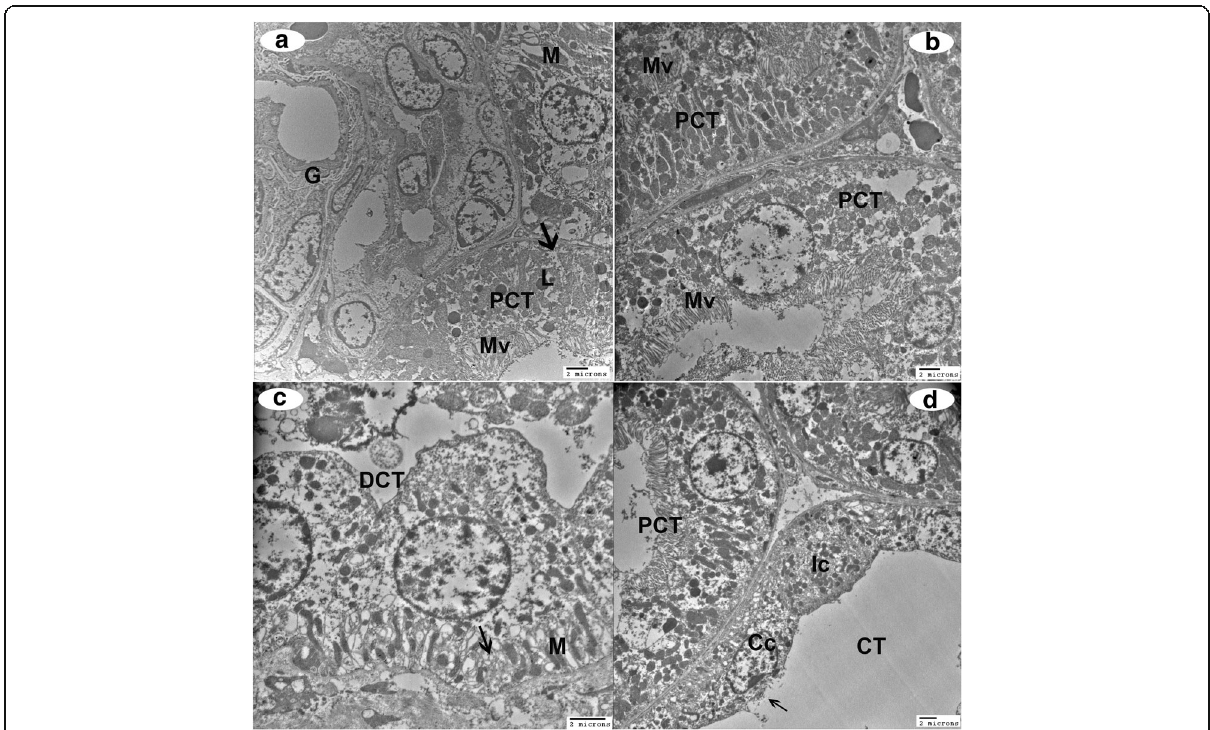
Fig. 4 Electron micrographs of the rat cortex of WR group. a Severe vacuolation in the glomerulus (G) and PCT, fragmented microvilli (Mv), damaged mitochondria (M), fragmented basal enfolding (arrow), and many lysosomes (L). b Lining cells of PCT with varying degrees of vacuolation and microvilli fragmention (Mv). c Cellular vacuolation of DCT, few and damaged mitochondria (M), and disorganized basal enfolding (arrow). d Varying degrees of cellular vacuolation in the PCT and CT, clear cell (Cc) with fragmented membrane (arrow), and intercalated cells (Ic) with disorganized and damaged mitochondria (scale bar = 2 μ